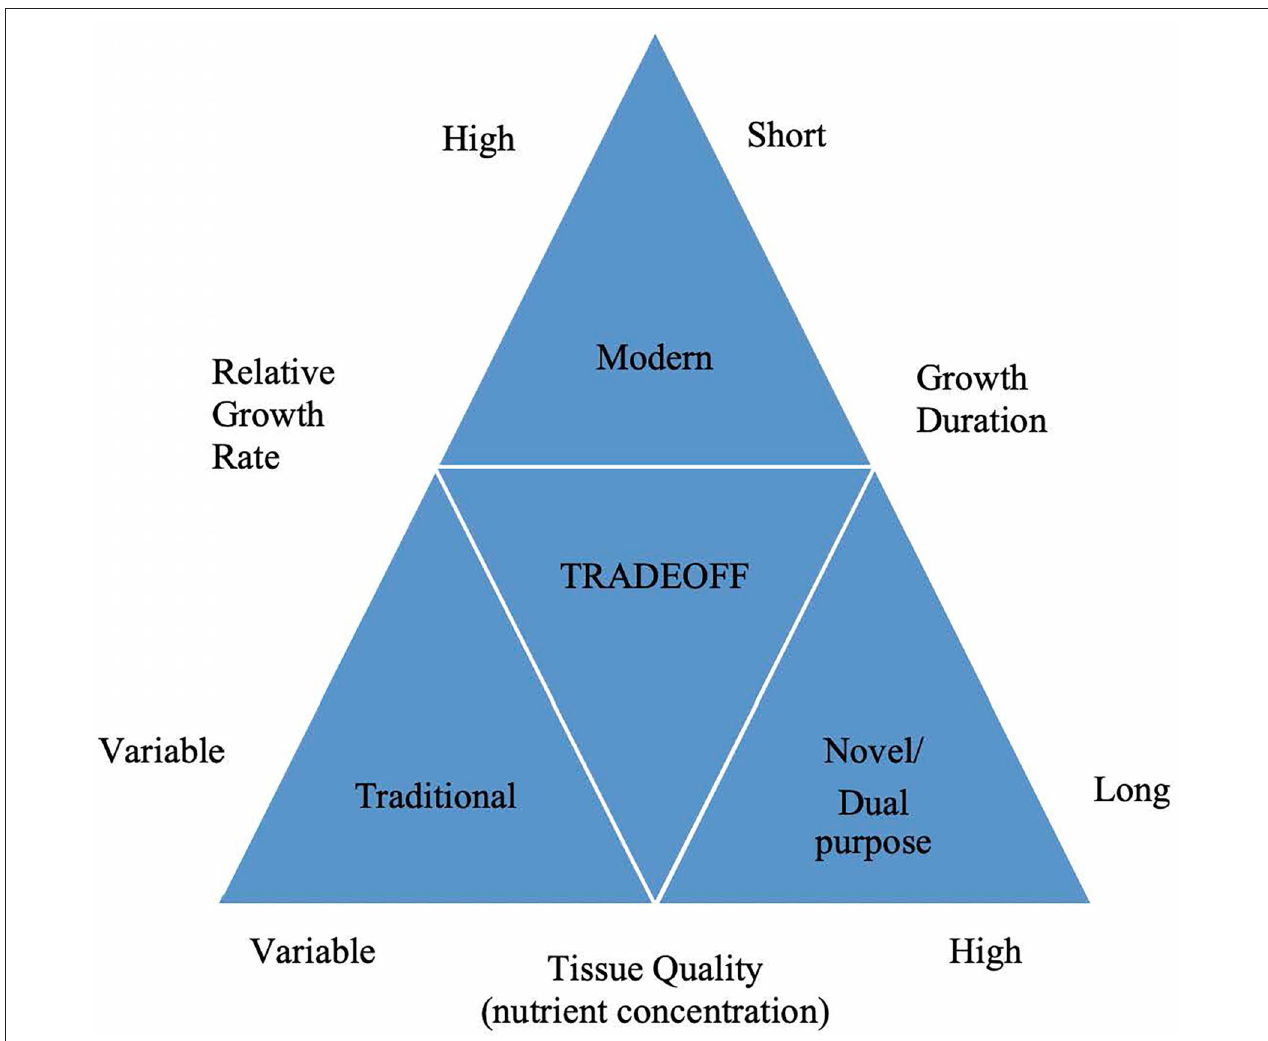
FIGURE 2 | A conceptual diagram of tradeoffs associated with plant traits associated with the rate and duration of growth, and tissue quality. Modern, improved cultivars of food crops are generally associated with relatively rapid growth rates and short duration, to achieve early vigor, and a high crop yield. Traditional varieties vary markedly in relationship to these traits, and novel plant breeding efforts have emphasized long duration of growth for dual purpose use, or high nutrient concentration for